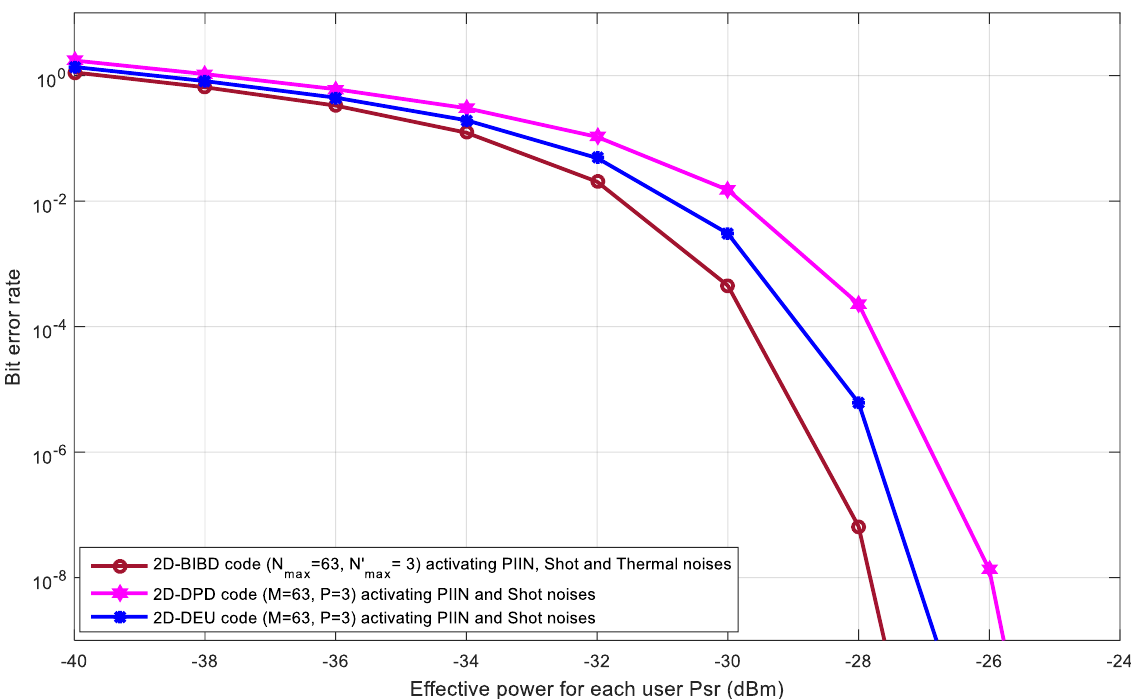
Figure 5. Relationship between BER and effective source power for specific 20 users at a data rate of 622 Mbps.